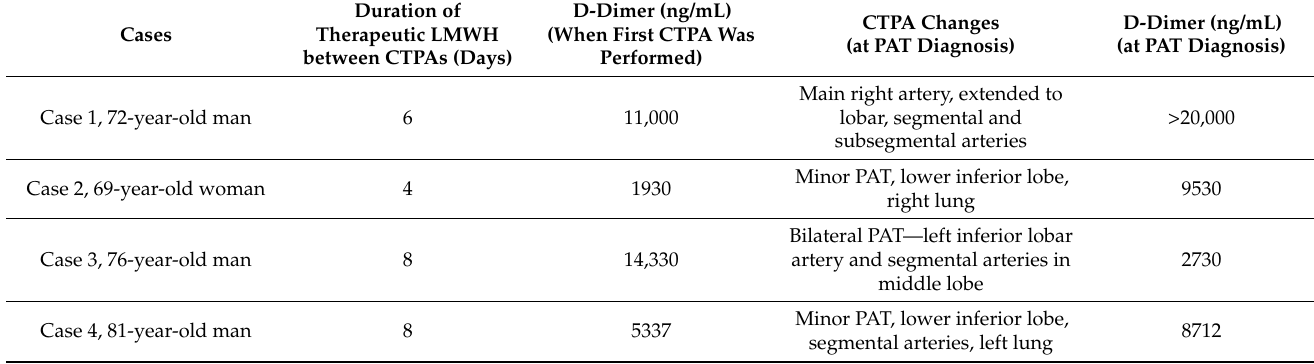
Table 2. Duration of therapeutic LMWH, CTPA and D-dimer changes in patients with a first CTPA excluding